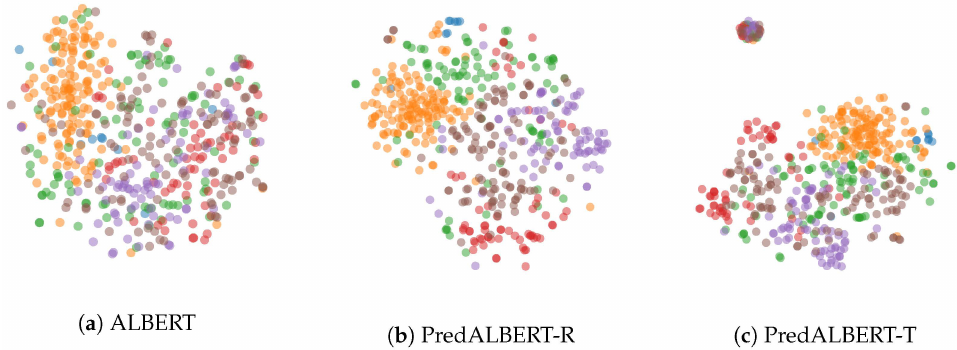
Figure 4. TSNE visualization of the embedding space learned on TREC [64] for ALBERT and PredALBERT in English. Each color indicates a ground truth semantic category.